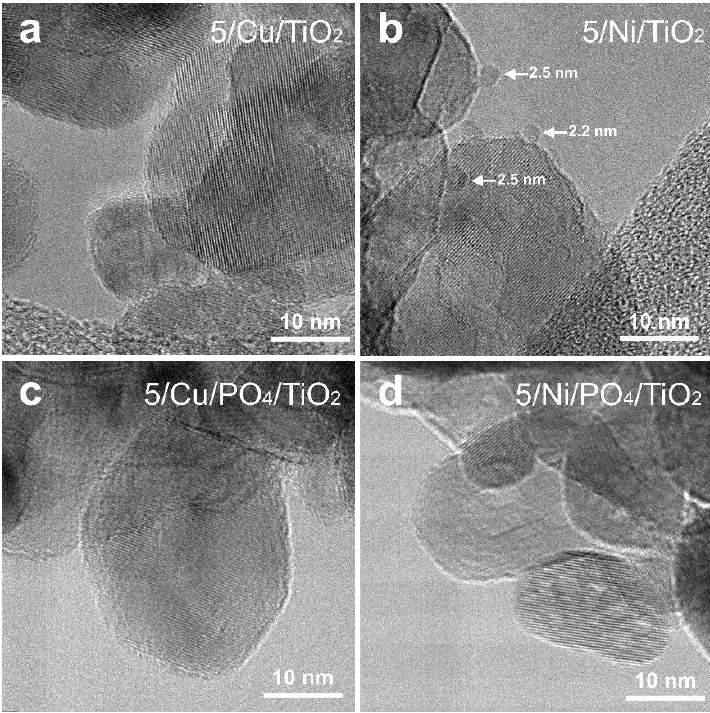
Figure 4. HRTEM images for the composites: ( a ) 5/Cu/TiO 2 , ( b ) 5/Ni/TiO 2 , ( c ) 5/Cu/PO 4 /TiO 2 and ( d ) 5/Ni/PO 4 /TiO 2 .